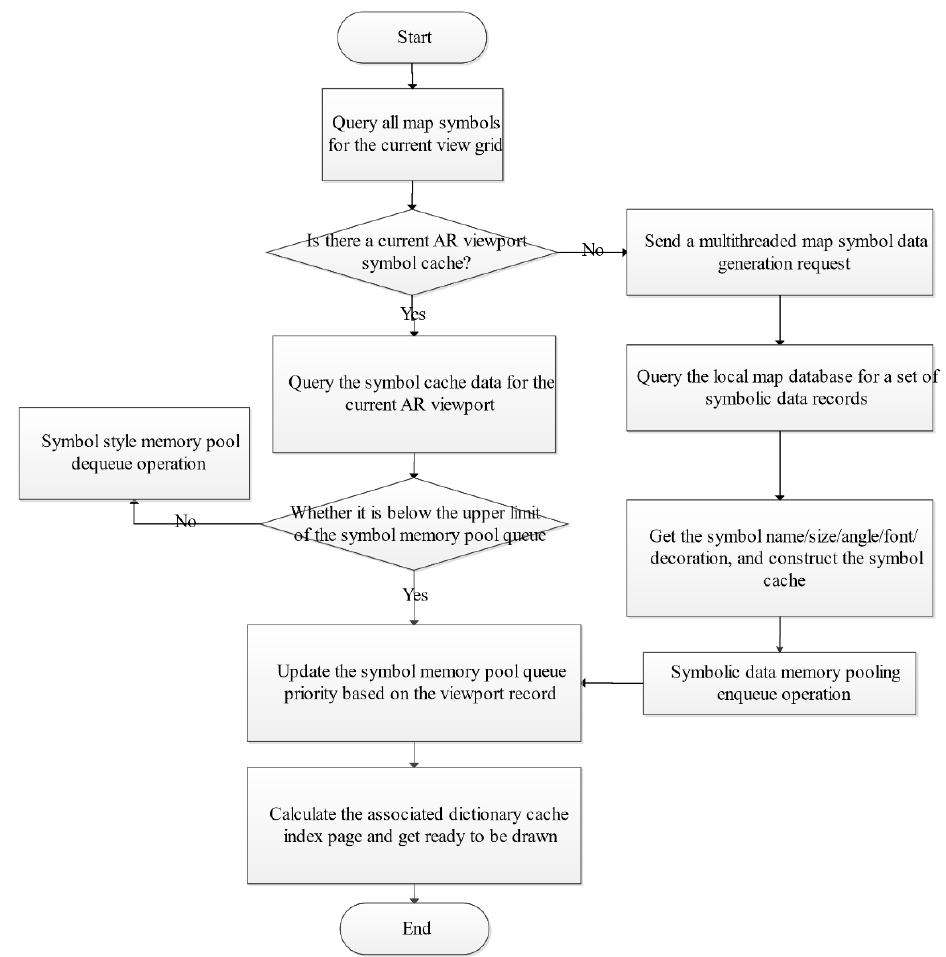
Figure 6. The principle of map symbol pre-caching in the AUGL engine.